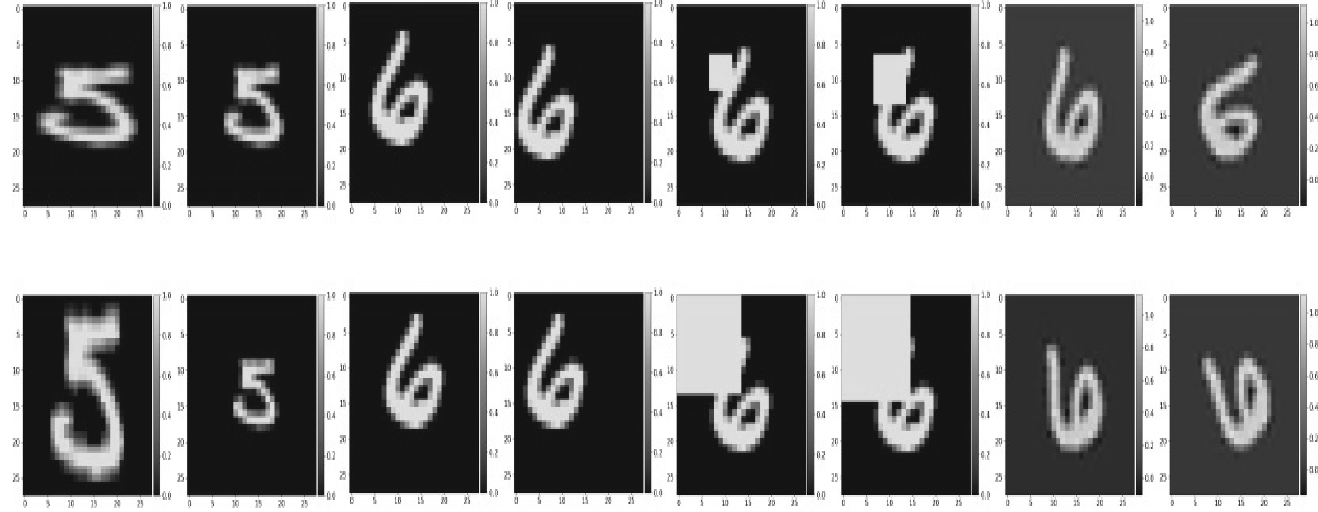
Figure 3. Sample images from the obstruction, rotation, rescaling, and displacement tasks with different